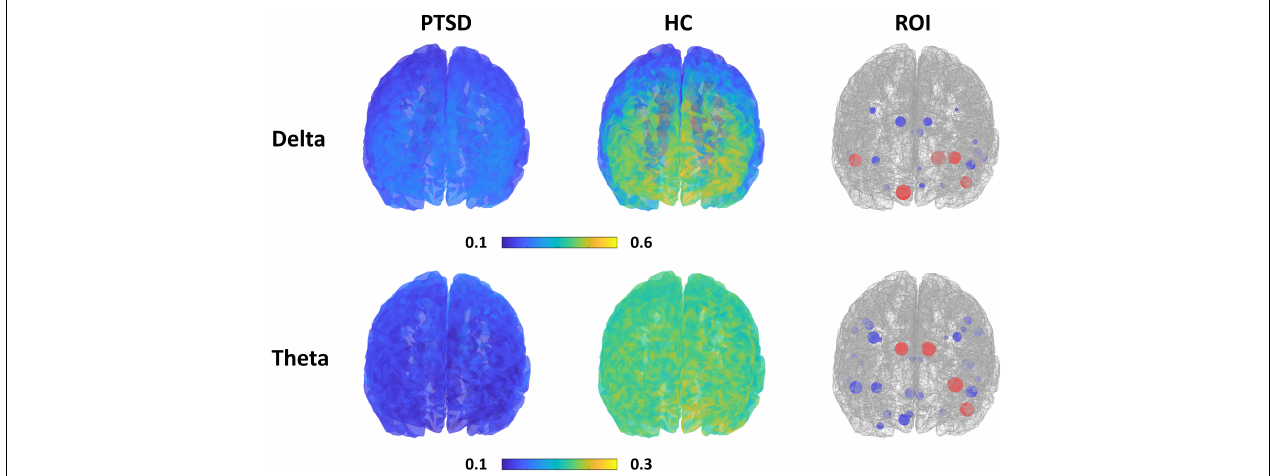
FIGURE 3 | Spatial PSD distributions for each group (first and second column) with respect to the frequency band, and the ROIs selected when achieving the maximum classification accuracy for each frequency band (third column). Red circles represent the important ROIs that have SVM coefficients over the upper bound of 95% confidence interval and blue circles indicate the other selected ROIs. The size of circles is proportional to SVM